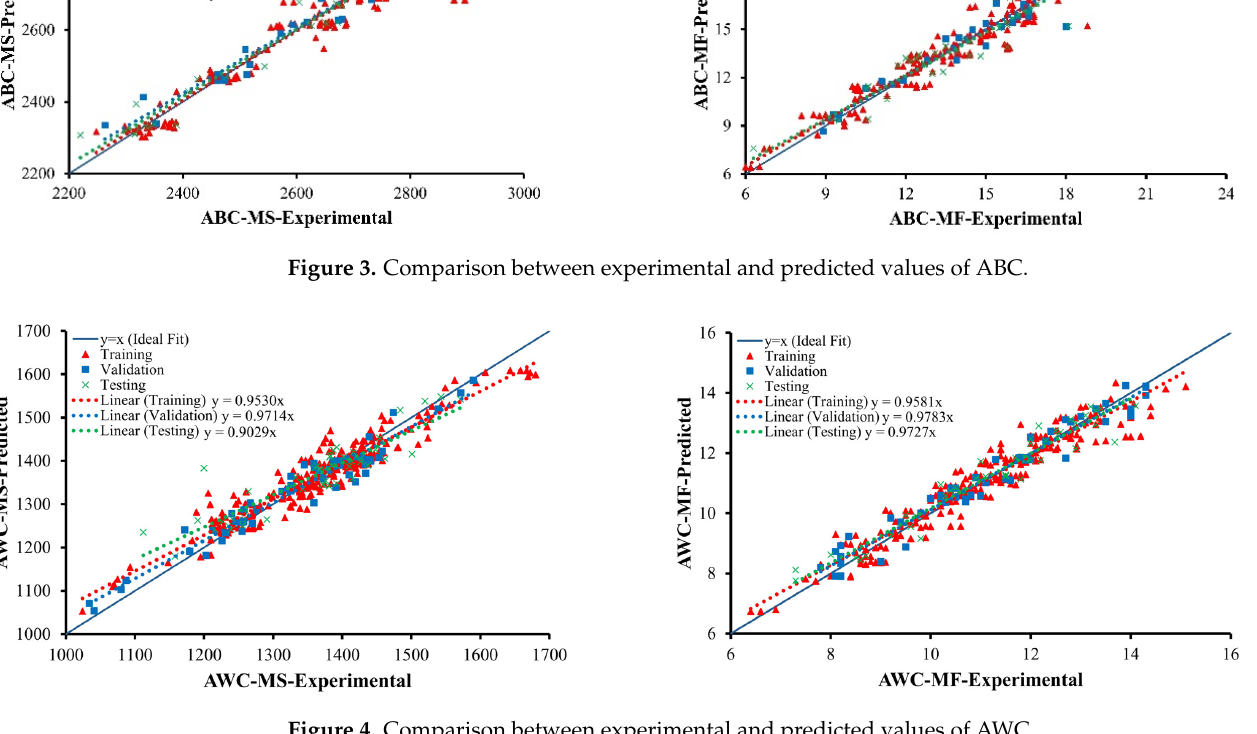
Figure 4. Comparison between experimental and predicted values of AWC.